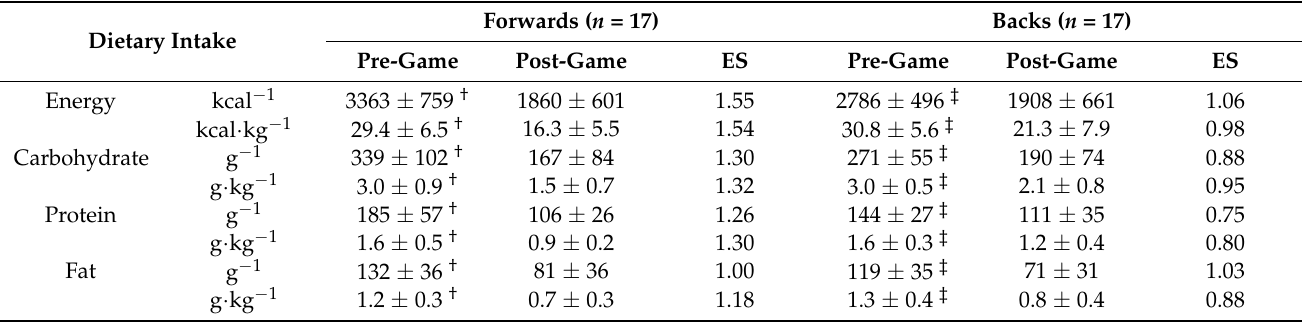
Table 3. Energy and macronutrient intakes pre-game (first meal of day to last meal prior to kick-off) and post-game within forwards and backs. Forwards ( n = 17) Backs ( n = Dietary Intake